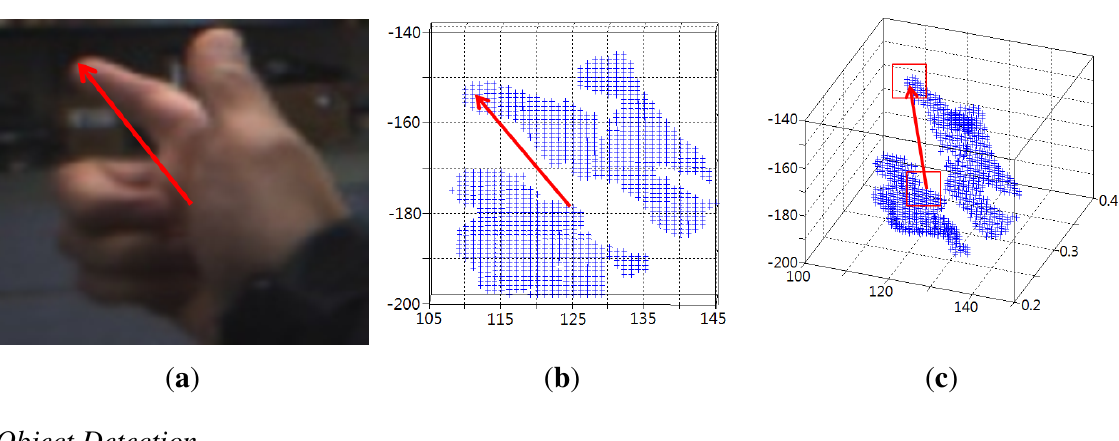
Figure 4. Estimation of a 3D pointing direction: ( a ) a 2D pointing vector; ( b ) a hand area projected onto the x - y plane; and ( c ) an estimated 3D vector from the corresponding 2D pointing